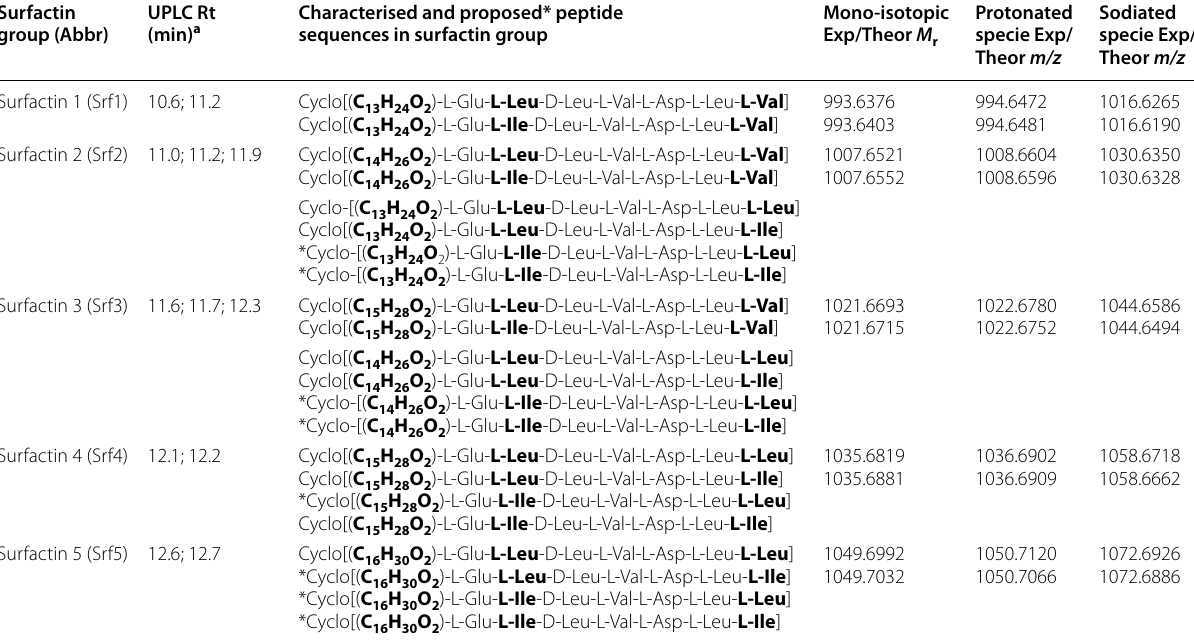
Table 3 Summary of the detected surfactin lipopeptides extracted from cultures of B. amyloliquefaciens ST34, as detected using high resolution mass spectrometry (<10 ppm) Surfactin Characterised and proposed* peptide group (Abbr) sequences in surfactin